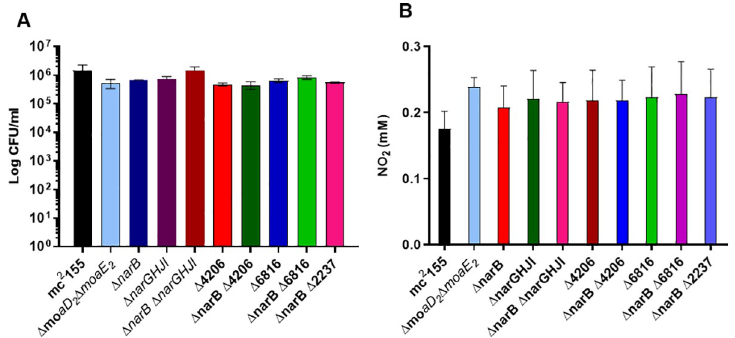
Fig 4. NR activity is not required for the survival of M . smegmatis under anaerobic conditions. (A) Anaerobic survival of the mutant strains was determined by enumeration of CFU’s after 6 days of anaerobiosis in the presence of nitrate and no differences were observed. (B) The modified Griess assay revealed that all the strains tested are unable to utilize nitrate under anaerobic conditions. The average of three independent experiments was plotted for each panel and standard errors are depicted. ���� Statistical significance was determined by 2way-ANOVA. ND: Not